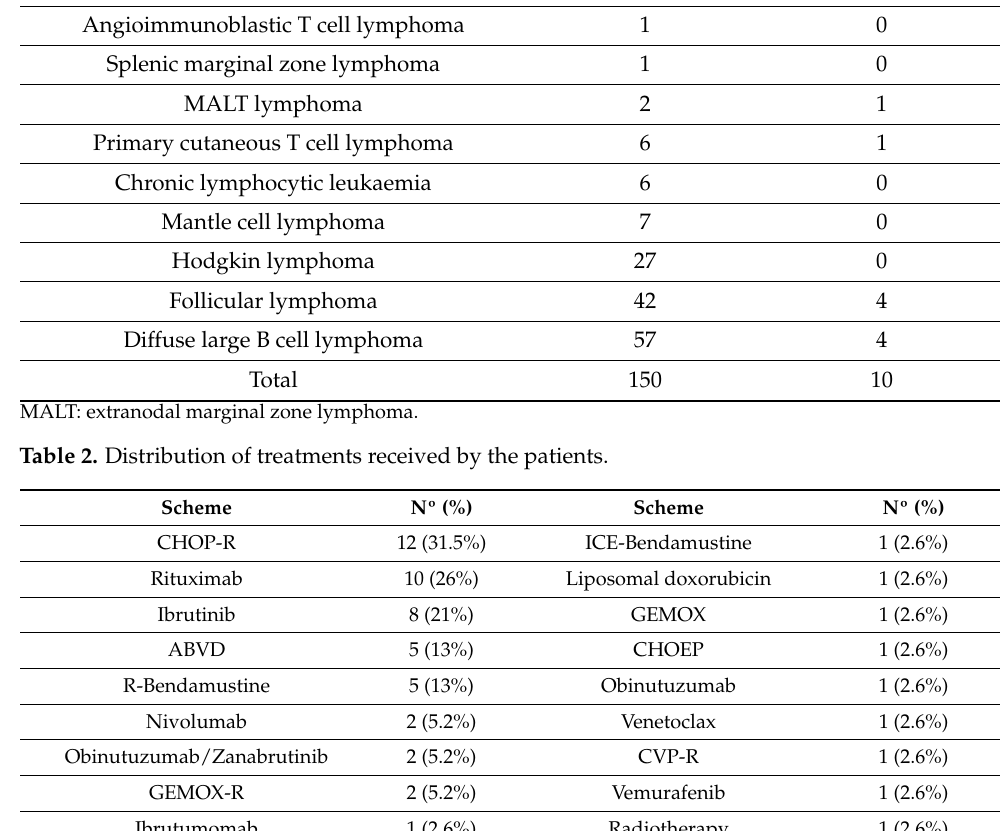
Table 1. Total cases according to the histological type and distribution of positive cases of IgG. Type of Neoplastic Nº IgG + Erdheim–Chester disease